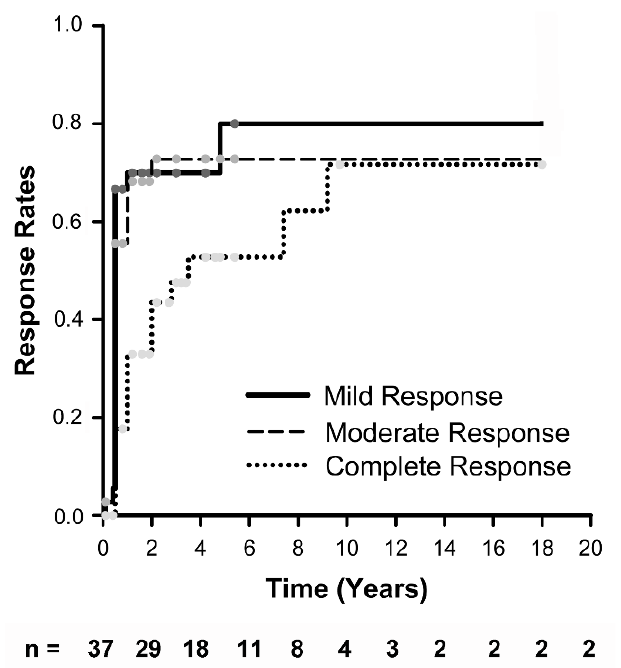
Figure 3. Kaplan–Meier analysis of kidney responses. Proportions of male patients with cSLE and nephritis having achieved at least mild (solid), moderate (dashed), and complete responses (dotted line) were plotted over time in years. The number of patients followed at each time point is listed beneath the plot. Response definitions are taken from the CARRA consensus treatment plans for childhood-onset lupus nephritis (23). Table 4. Outcomes of males with childhood-onset lupus